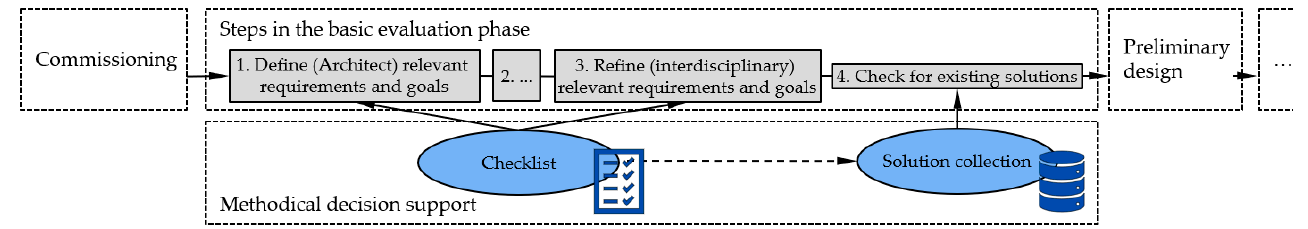
Figure 4. Deriving decision support for the basic evaluation phase of AF design.